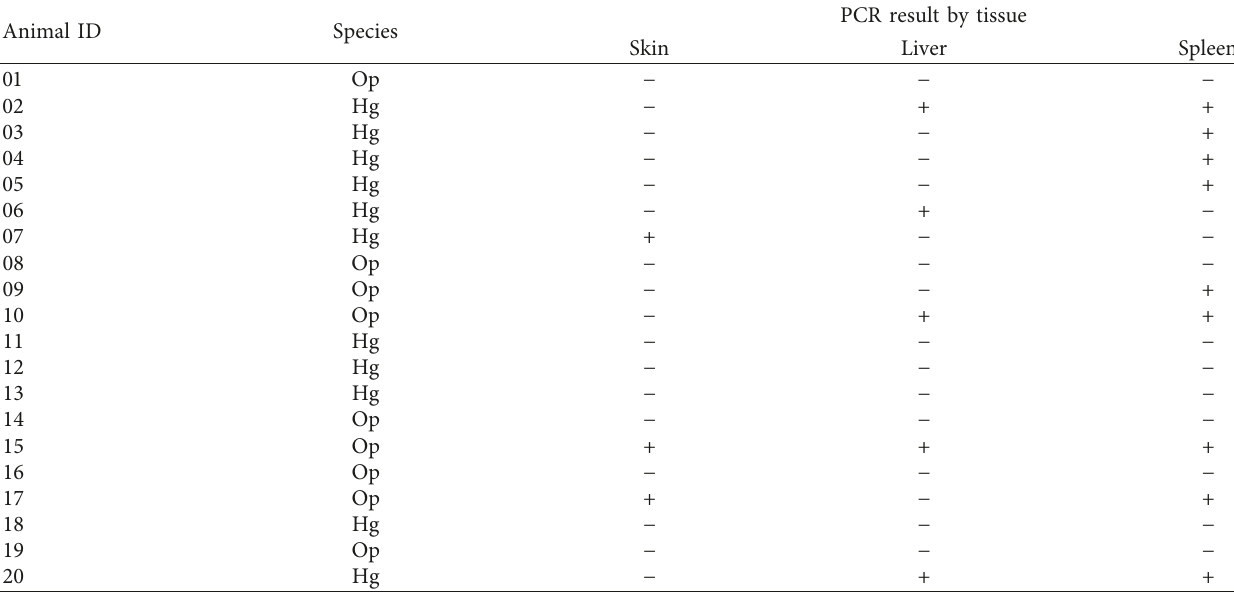
Figure 2: Illustrations of the Heteromys gaumeri (a) and Ototylomys phyllotis (b) specimens caught in Tinum, Yucatan. White spots suggestive of Leishmania infection in the tail of one H . gaumeri (c) and hepatomegaly (blue arrow) and splenomegaly (red arrow) in one O . phyllotis (d). Table 1: Molecular results for Leishmania infection in the different